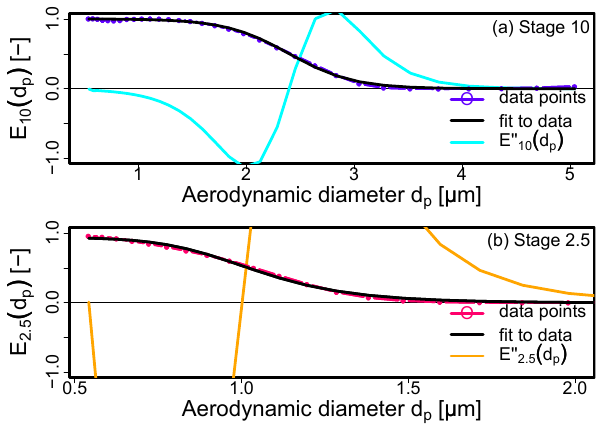
Fig. 3. Stage penetration curve E i (cid:0) d p (cid:1) for stages 10 and 2.5: ratio of size distributions obtained in setup B versus size distributions ob- tained in setup A. The upper panel (a) shows the ratio for stage 10, a sigmoidal fit was applied to data points. The second derivative 00 (cid:0) d (cid:1) is shown on the same axis scale. The lower panel (b) shows E p i data points and sigmoidal fit for stage 2.5, E same axis scale.